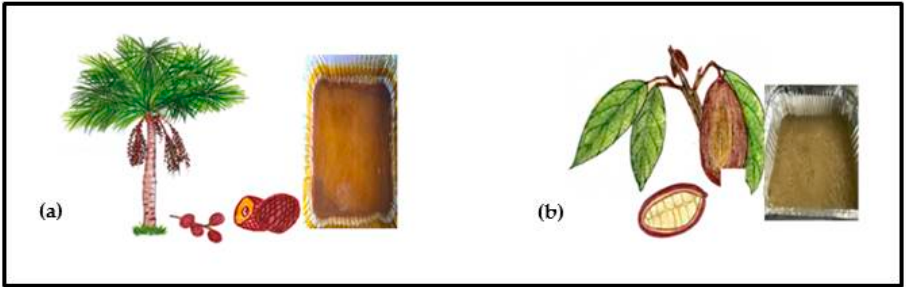
Figure 1. ( a ) Mauritia flexuosa (aguaje) palm, fruit [15], and seedless pulp; ( b ) Theobroma grandiflorum (copoazú) plant, fruit [15], and seedless pulp.